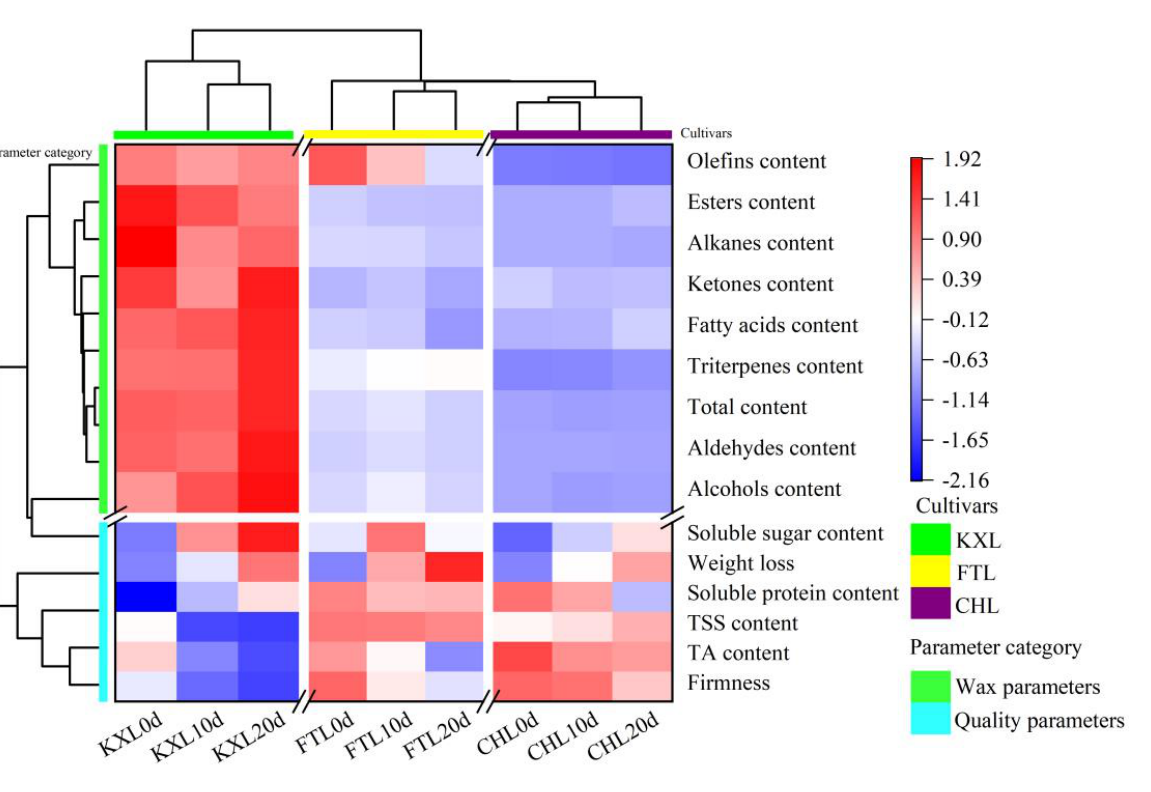
Figure 5. Cluster analysis of wax composition and fruit quality among three plum cultivars during storage at room temperature. Note: the color ranges from blue to red indicates low to high correlation coefficients.